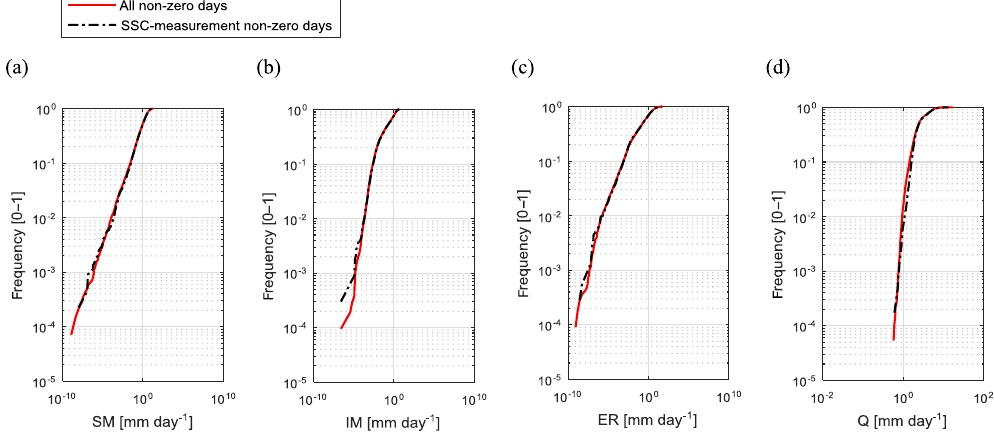
Figure 11. Empirical cumulative distribution functions of total daily basin-averaged SM (a) , IM (b) , ER (c) , and Q (d) , computed on all days and only on days corresponding to SSC measurements. Only non-zero values of SM, IM and ER, are